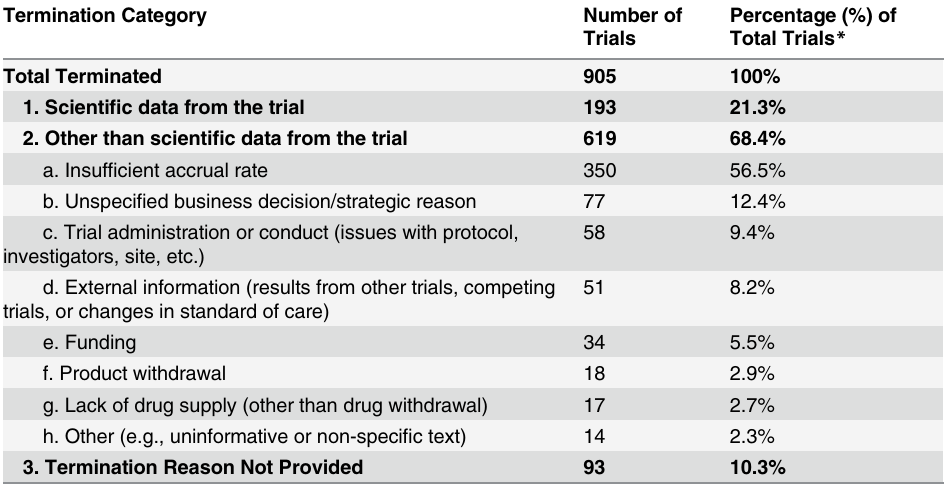
Table 1. Reason for termination categorization.